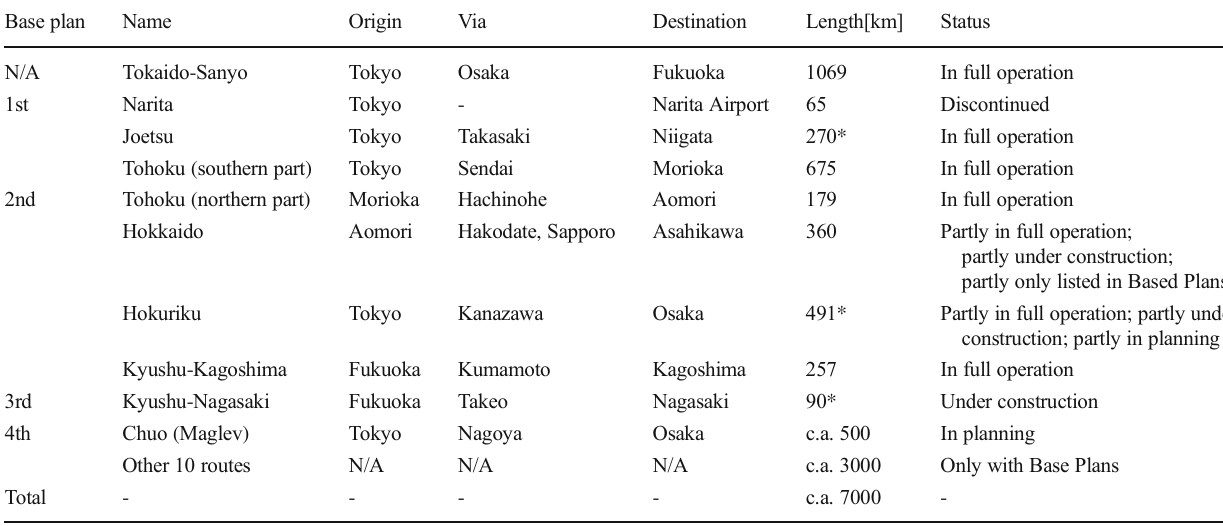
List of Shinkansens with Development Plan already made, Source: MLIT Base